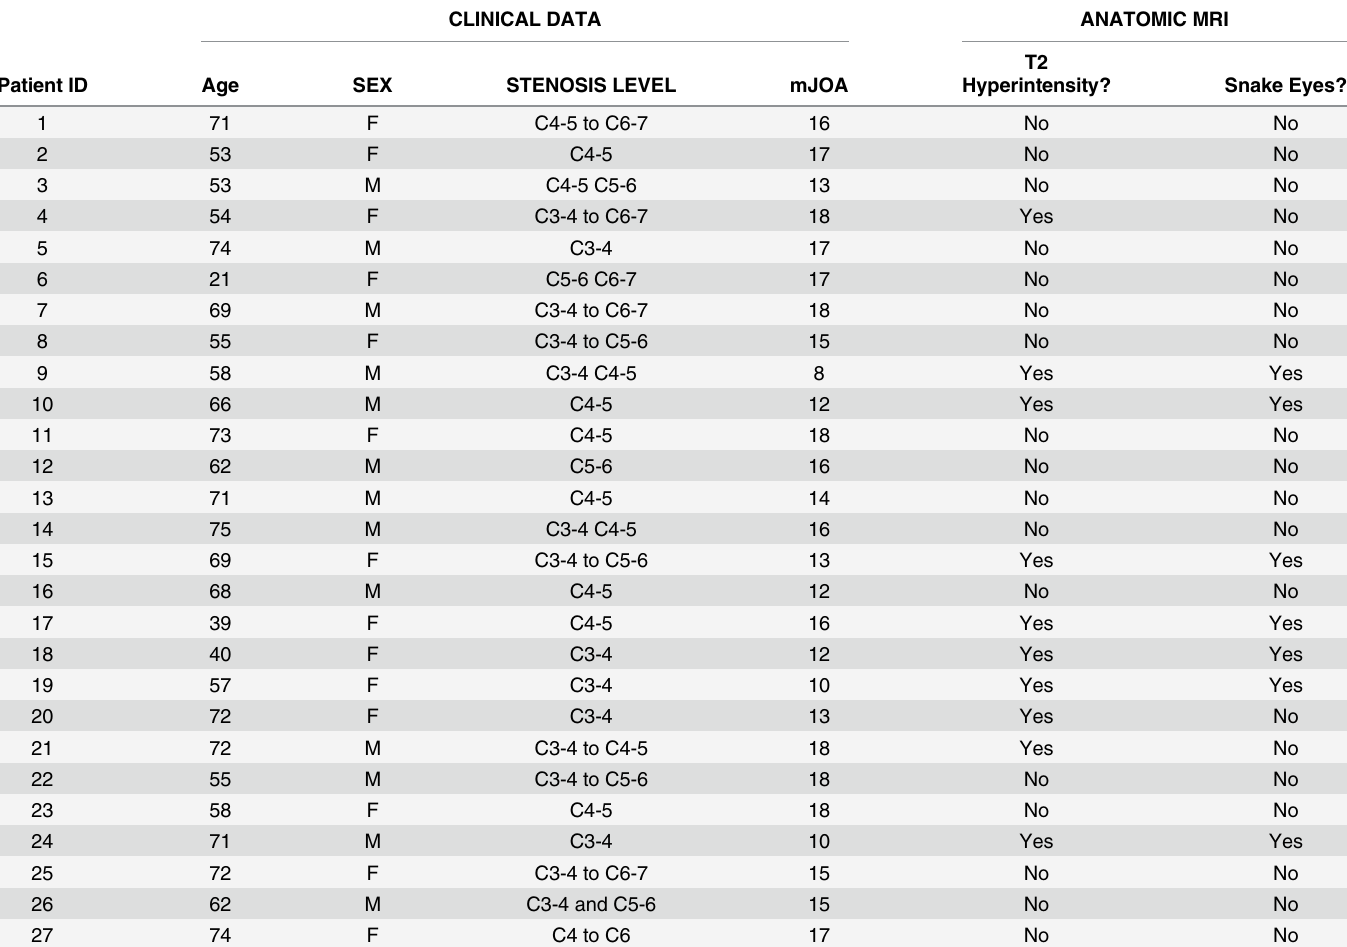
Table 1. Patient Clinical and Demographic Information. mJOA = Modified Japanese Orthopedic Association score. SEA = “ Snake Eye ” appearance. CLINICAL